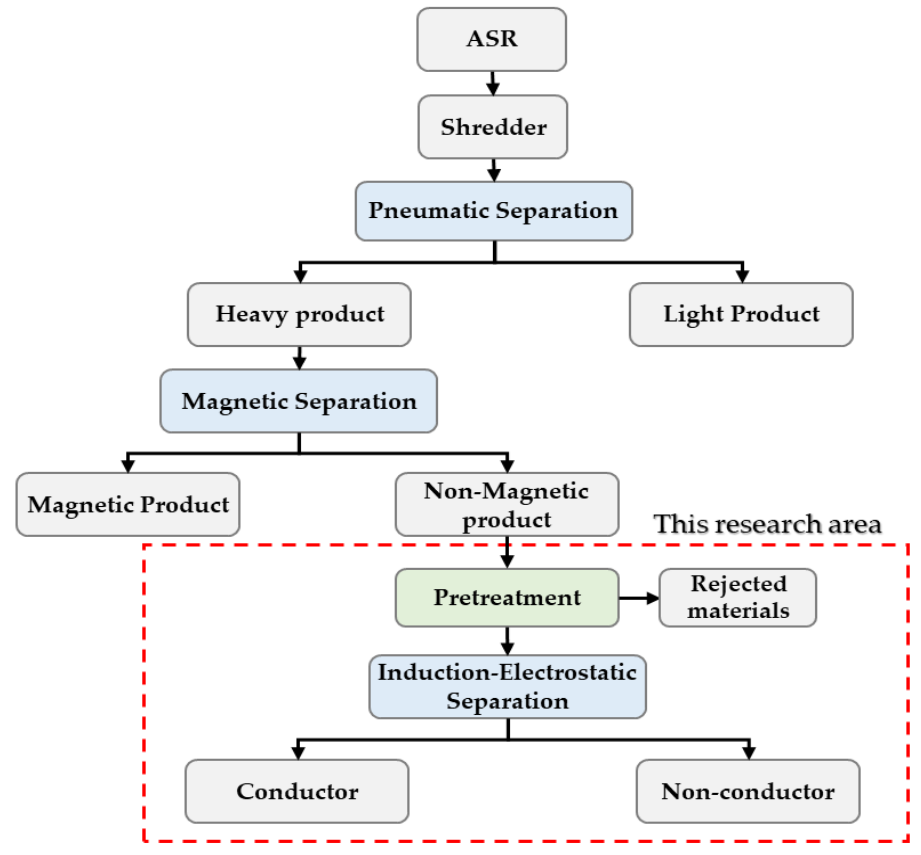
Figure 2. Flowchart of ASR separation process.